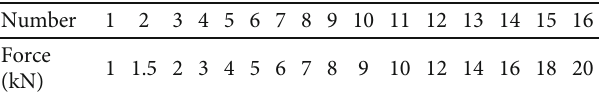
Table 3: Axial preload of fi nger